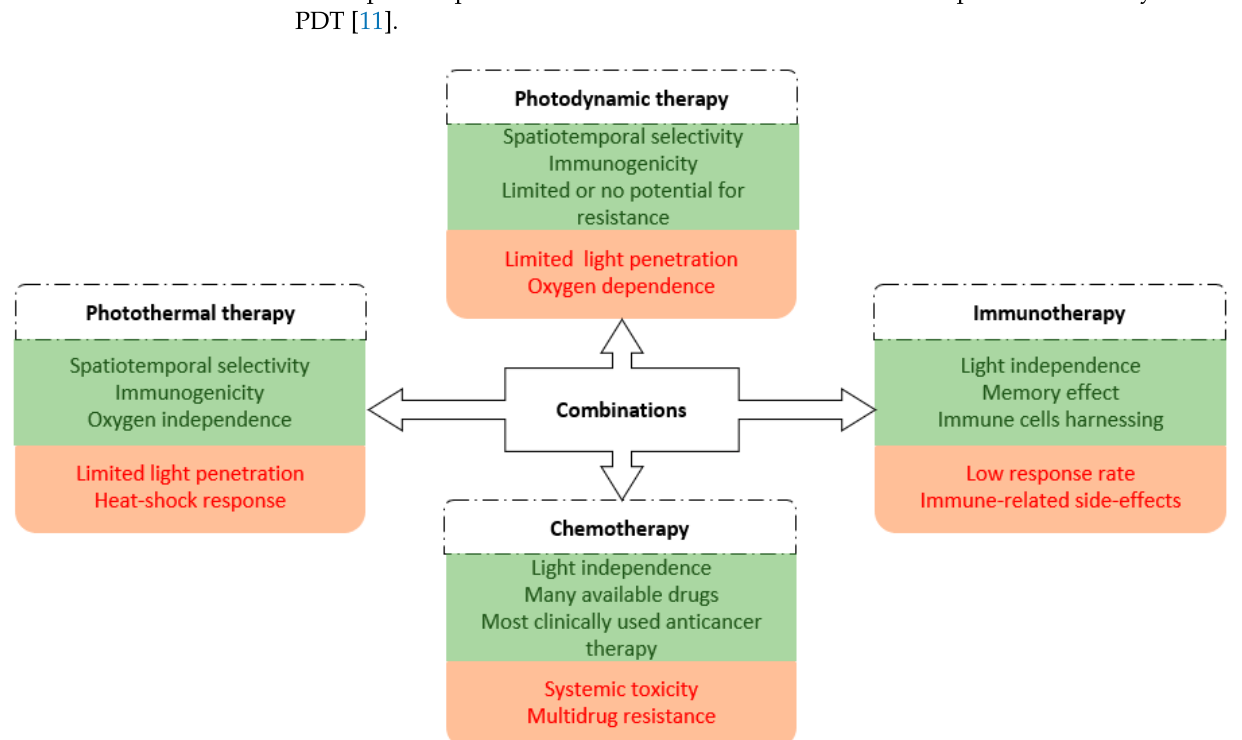
Figure 5. Possible combinations between PDT and other therapeutic strategies. Created based on literature reference [11].